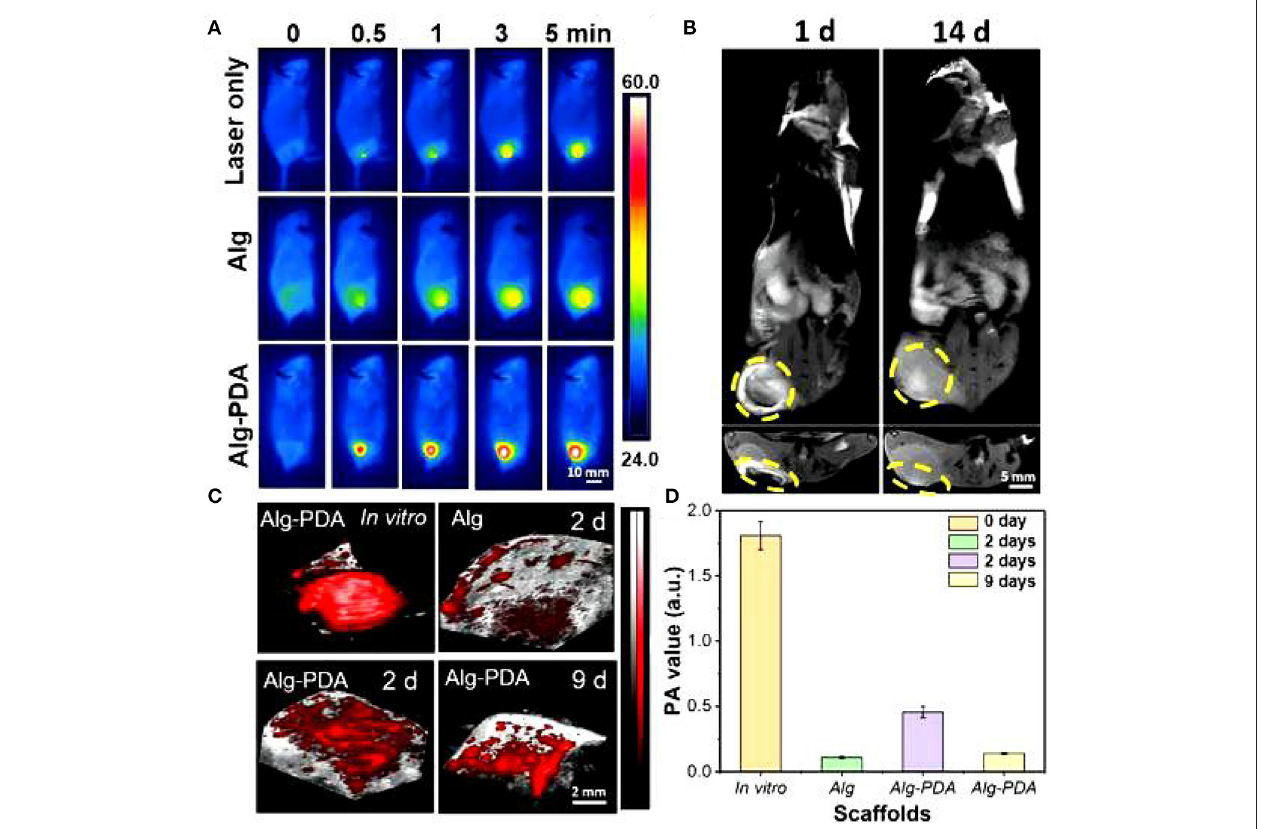
FIGURE 2 | MRI images of the breast cancer region implanted with Alg-PDA scaffold for 1 and 14 days (A) . Yellow circles indicate the location of the scaffold (B) . Photoacoustic imaging (C) and photoacoustic intensity (D) of Alg scaffolds and Alg-PDA scaffolds before ( in vitro ) and after implantation at tumor sites of mice for 2 and 9 days.